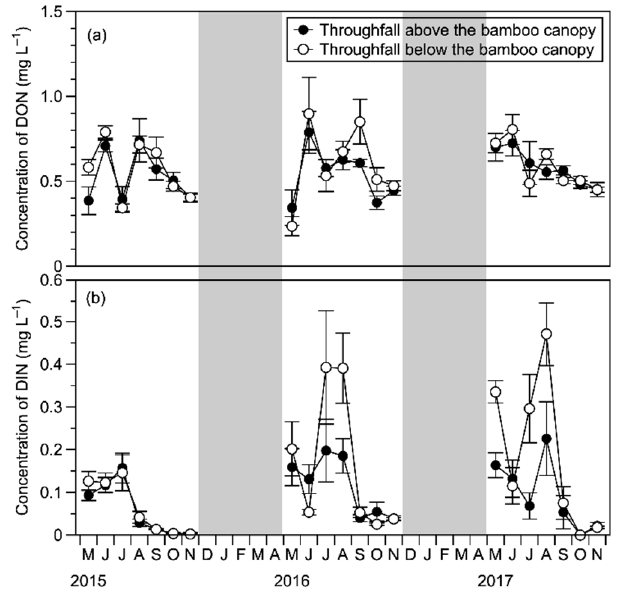
Figure 6. Average monthly concentration (mg L − 1 ) of dissolved organic nitrogen (DON) ( a ) and dissolved inorganic nitrogen (DIN) ( b ) in throughfall above and below the bamboo canopy from May 2015 to November 2017. Shaded areas show the snow seasons. Error bars show the standard error ( n = 9).